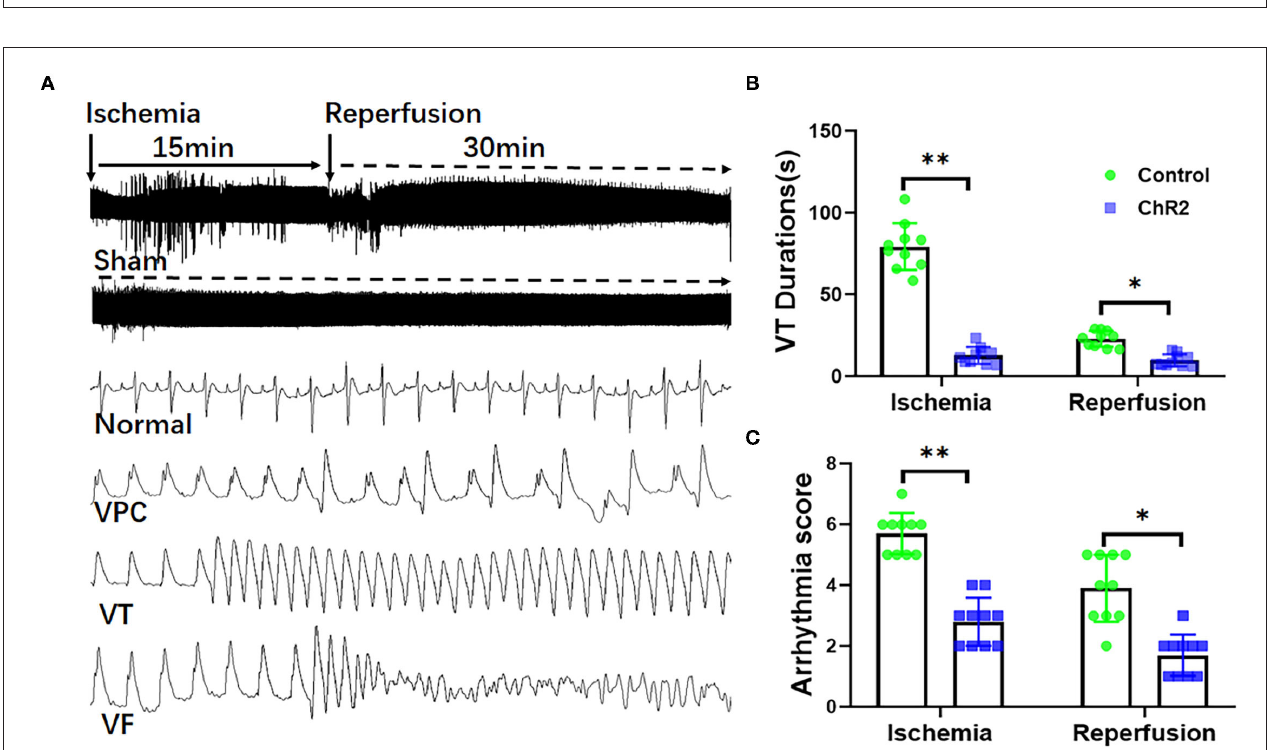
FIGURE 1 | and representative traces of EMG (E) . (F) mCherry-positive cells expressed major glutamatergic neuron marker VGLUT2, minor GABAergic neuron marker GAD65, but not cholinergic neuron marker ChAT. (G) The relative ratio of mCherry-positive neurons. A paired t -test was used to compare mCherry positive